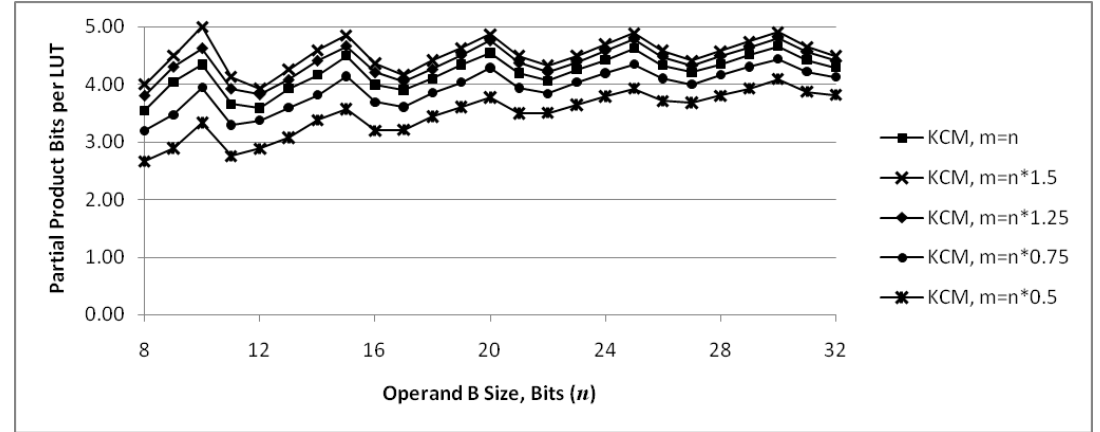
Figure 8. Number of partial product bits computed and summed per LUT6 as m and n are varied. KCMs with n ∈ { 10,15,20,25, . . . } are generally the most efficient, KCMs with n ∈ { 12,17,22,27, . . . } generally are the least efficient. For a given value of n , efficiency increases as m increases and decreases as m